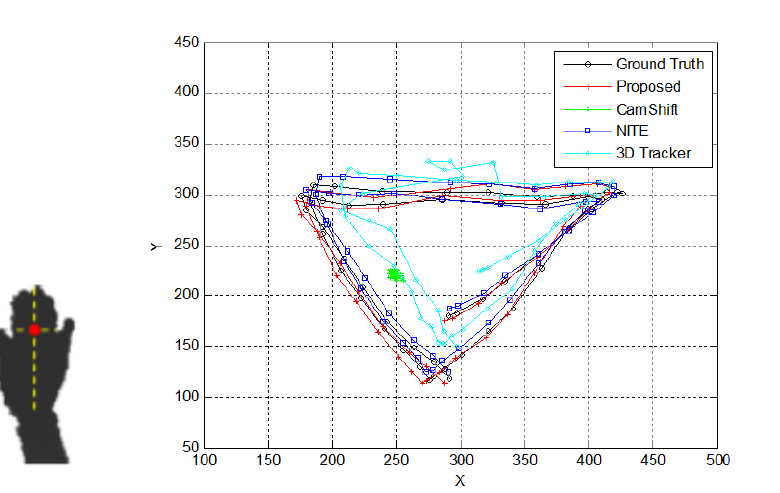
Figure 10. Ground truth (red dot) manually selected as one-third of the hand from the top ( Left ) and the measured trajectories by four methods for a triangle gesture ( Right